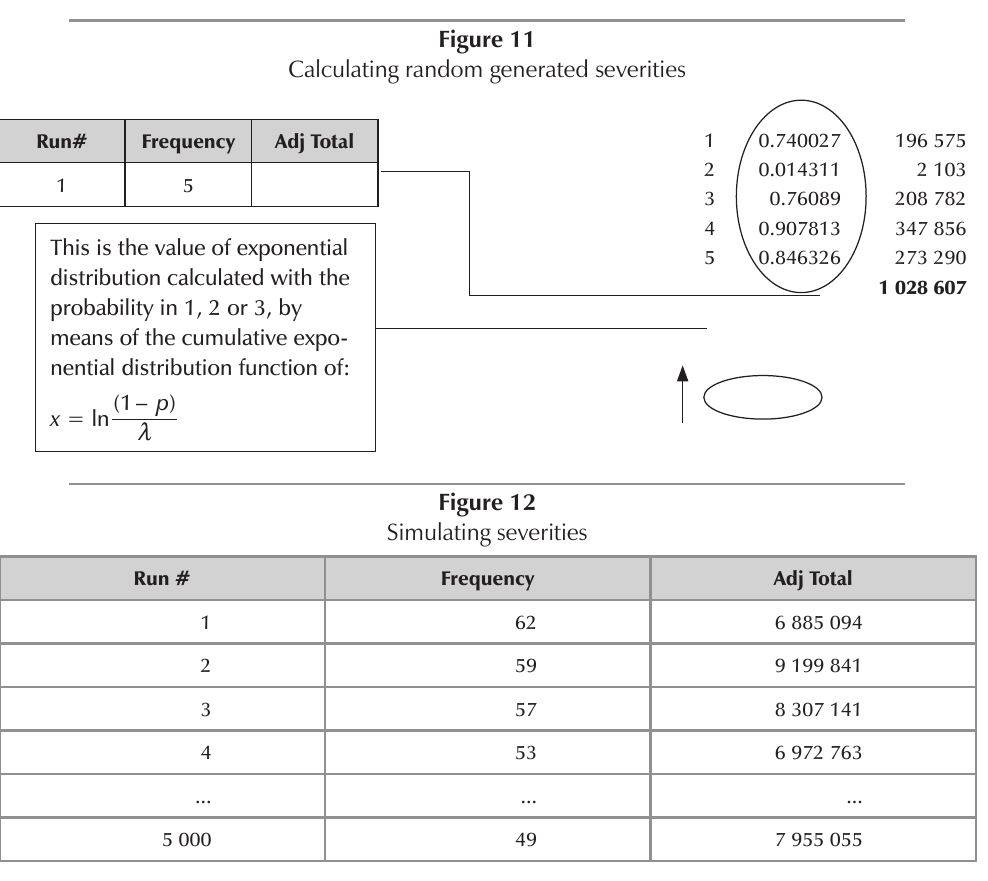
Figure 4 is a graphical representation of the severity distribution. It is important first to choose loss bands for the data, in this case 17, R1 million bands. The severity is calculated using Excel’s “frequency”